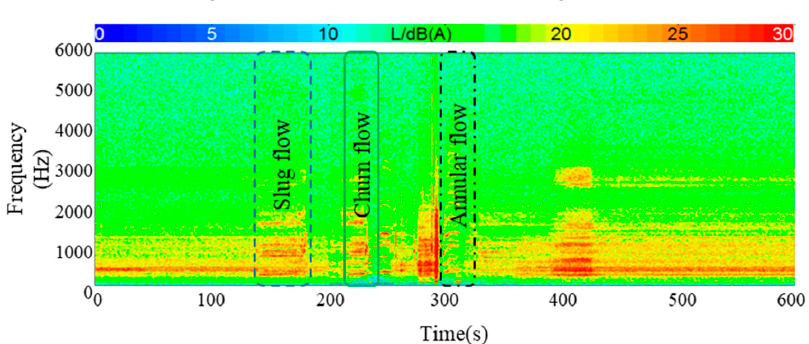
Figure 5. Slug, churn and annular noises of refrigerant flow noise.